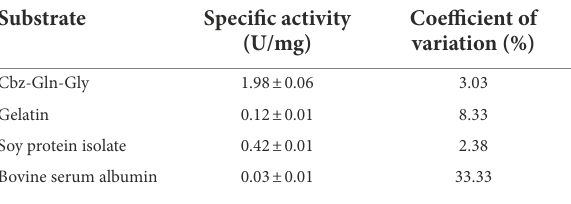
TABLE 3 The PG specificity toward different substrates.